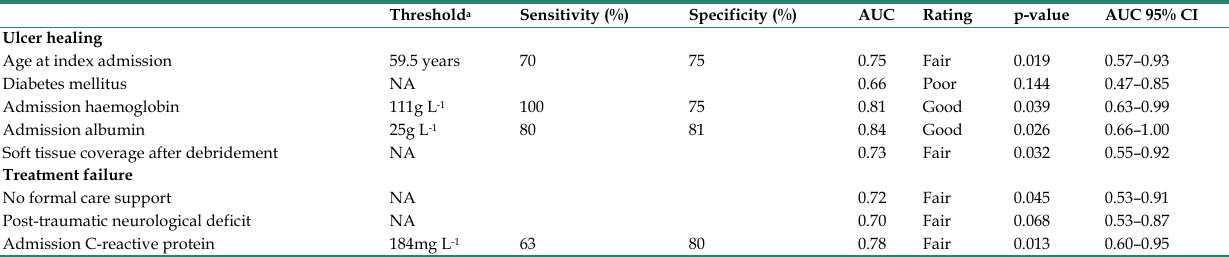
Table 2. Receiver operator characteristic analysis of risk factors associated with outcomes